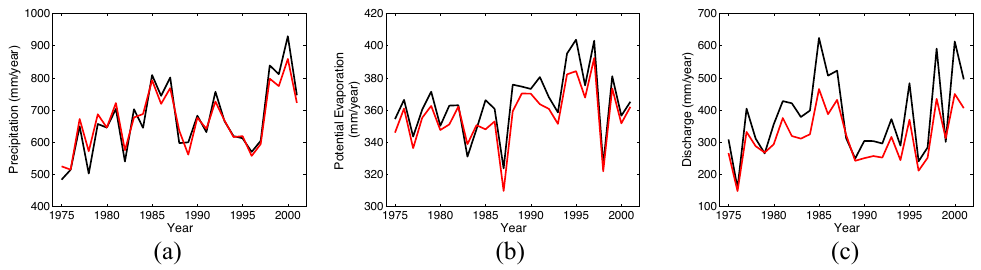
Fig. 11. Values of yearly precipitation (a) , potential evaporation (b) and discharge ( c) of the small sub-basin (outlined in green in Fig. 10), Figure 11. Values of yearly precipitation (a), potential evaporation (b) and discharge (c) of the 5 plotted by black lines, and a larger area (red cells in Fig. 10), plotted by red small sub-basin (green outlined in Figure 10), plotted by black lined; and a larger area (red 6 cells in Figure 10), plotted by red lines. 7